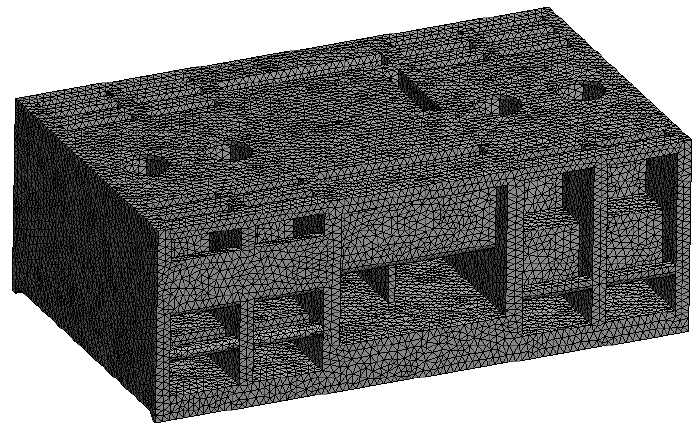
Figure 2. Finite element mesh of station building.